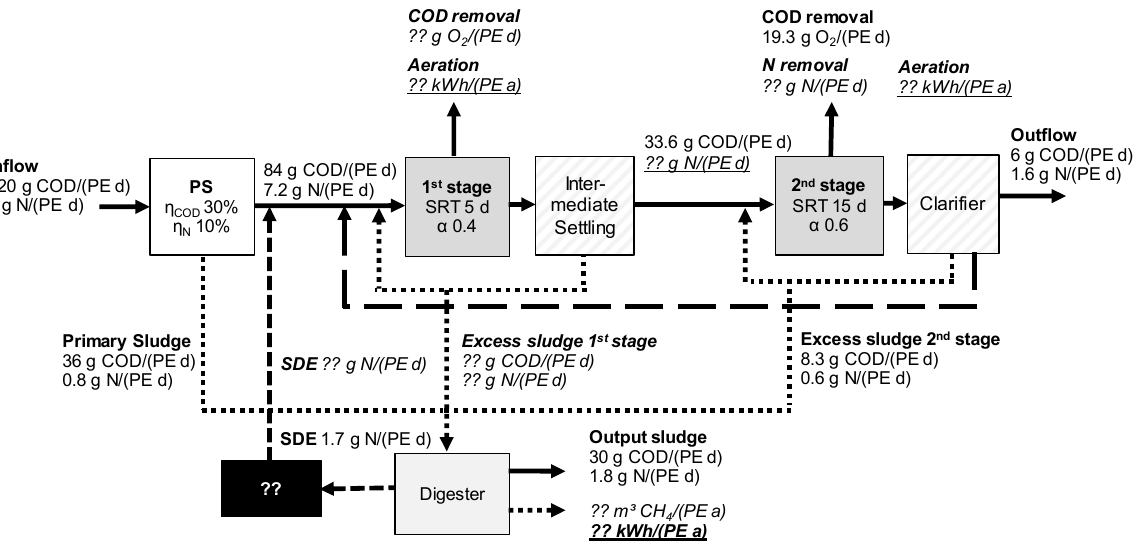
Figure 3. COD and N balances for two-stage activated sludge tanks .